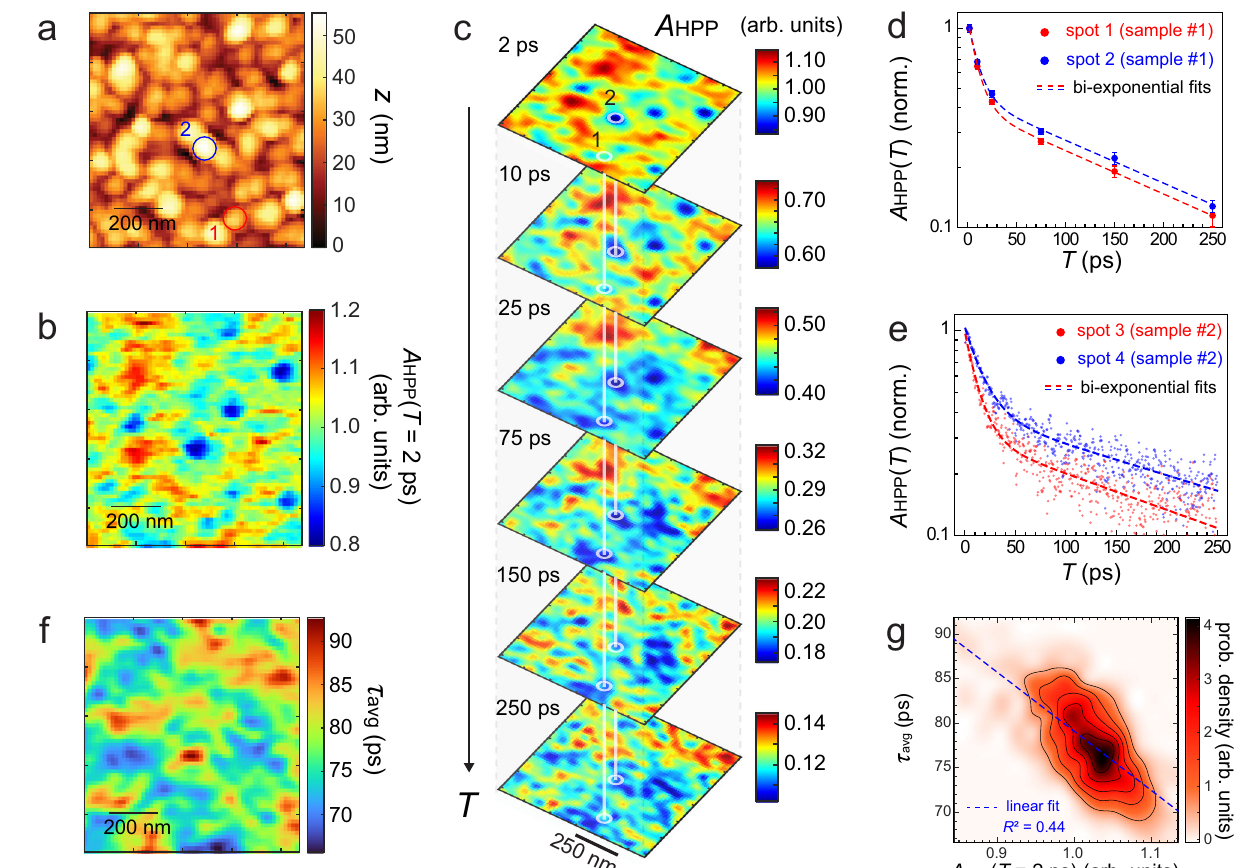
Fig. 2 | Ultrafast infrared nano-imaging of many-body carrier dynamics. AFM topography ( a ) and the corresponding heterodyne near- fi eld pump-probe signal amplitude A HPP ( T ) image( b ) acquiredwith the pump-probedelay T of2ps. c Time evolutionof A HPP ( T )demonstratingtheheterogeneityinultrafastcarrierformation and relaxation over hundreds of nanometers. d A HPP ( T ) decay pro fi les extracted at